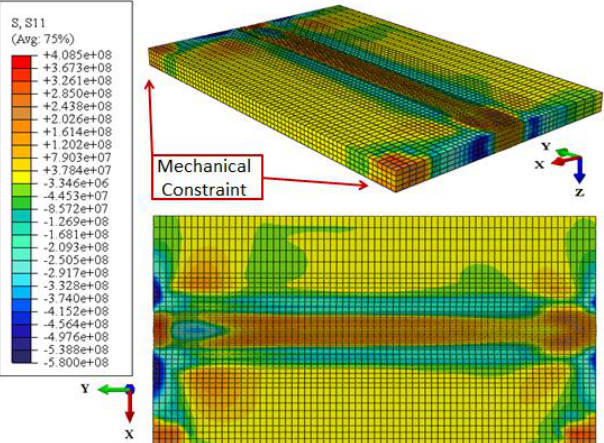
Figure 13. General transverse residual stresses obtained in the simulation with two passes after cooling to room temperature.